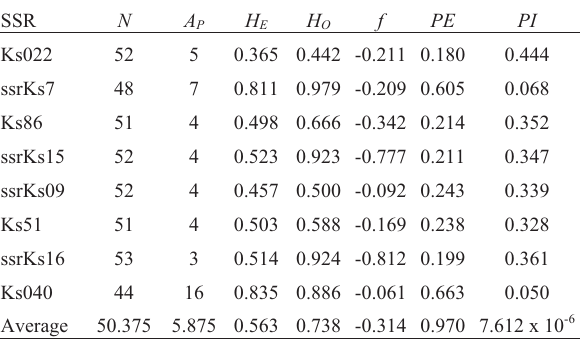
Table 2 - Estimates of genetic diversity parameters ( A P , H E , H O and f ) and probabilities ( PE and PI ) for the eight SSR markers genotyped in the 53 K. grandifoliola selected trees.